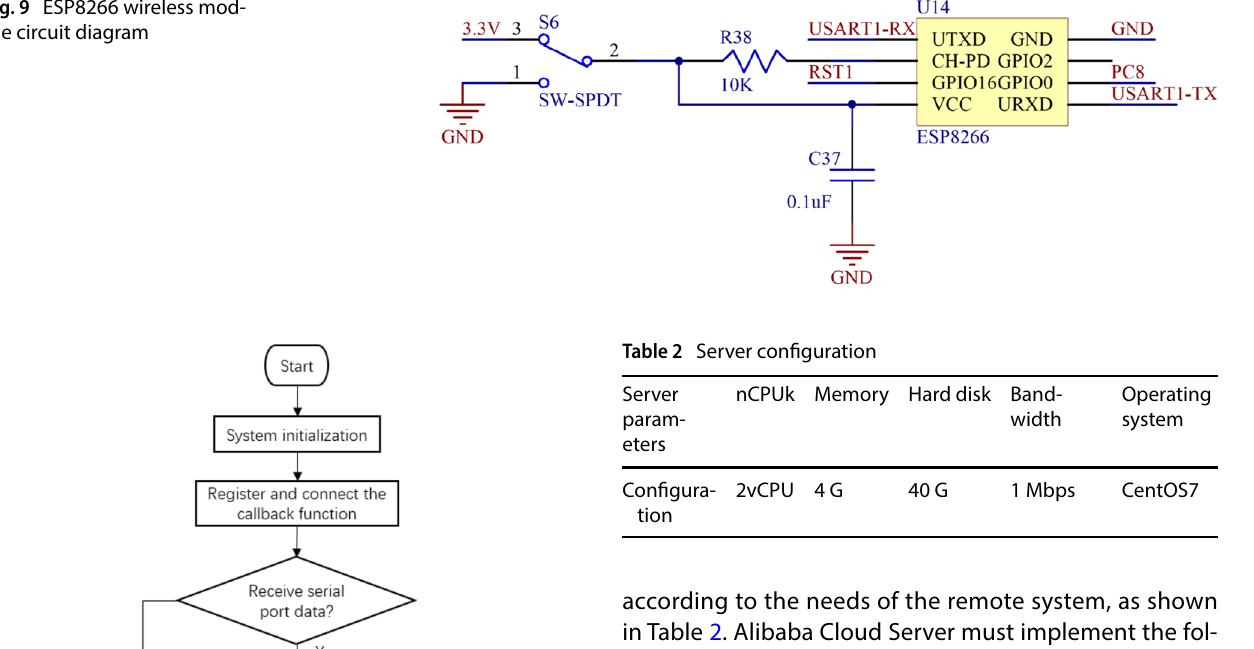
Fig. 9 ESP8266 wireless mod- ule circuit diagram